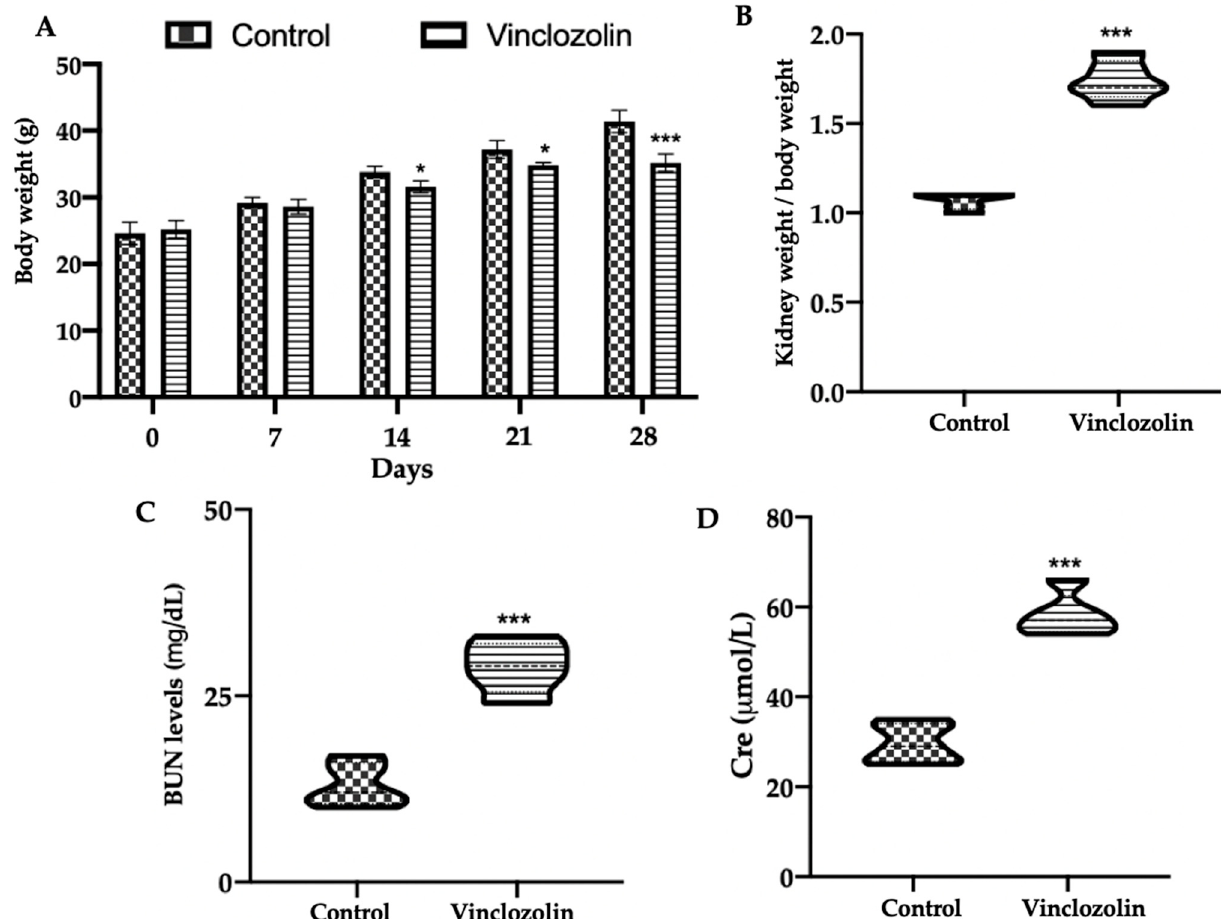
Figure 1. Effects of vinclozolin exposure on kidney function: ( A ) Body weight; ( B ) ratio of kidney weight to body weight; ( C ) BUN content; ( D ) Cre content. A p -value less than 0.05 was considered significant. * p < 0.05 vs. control, *** p < 0.001 vs. control.